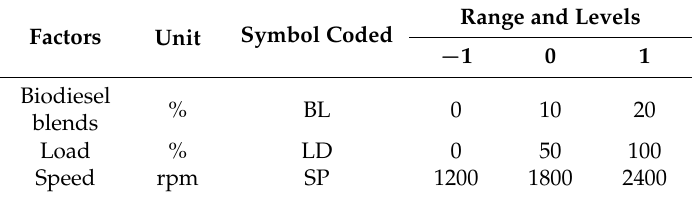
Table 7. Experimental range and levels coded for analysis of variance